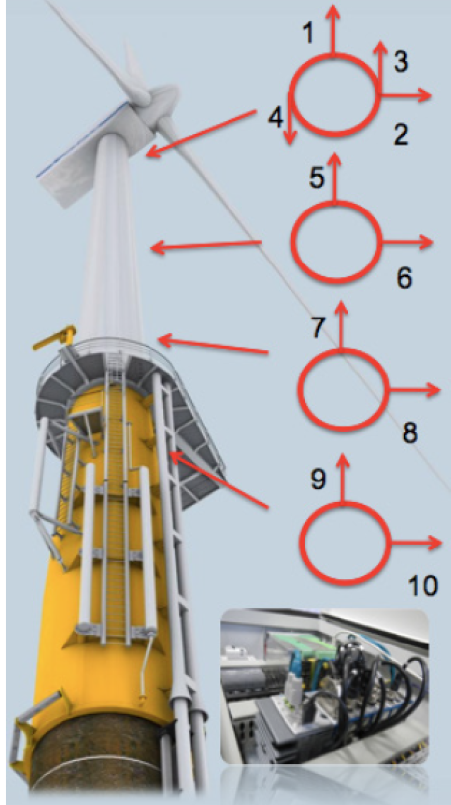
Figure 5. Example of tower instrumentation for damping estima- tion, with sensor locations and orientations (Manzato et al., 2014).